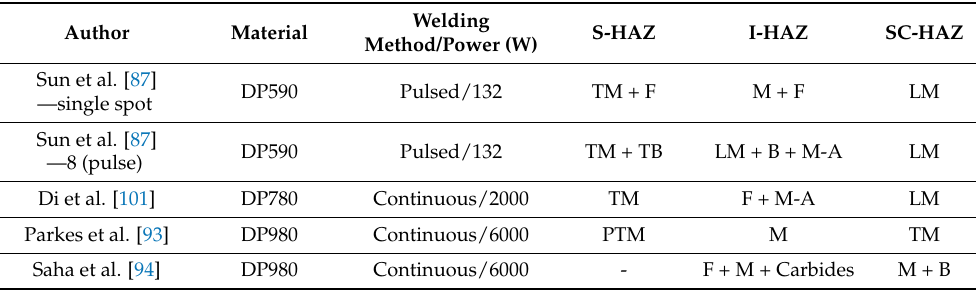
Table 4. Microstructural transformations in HAZ.